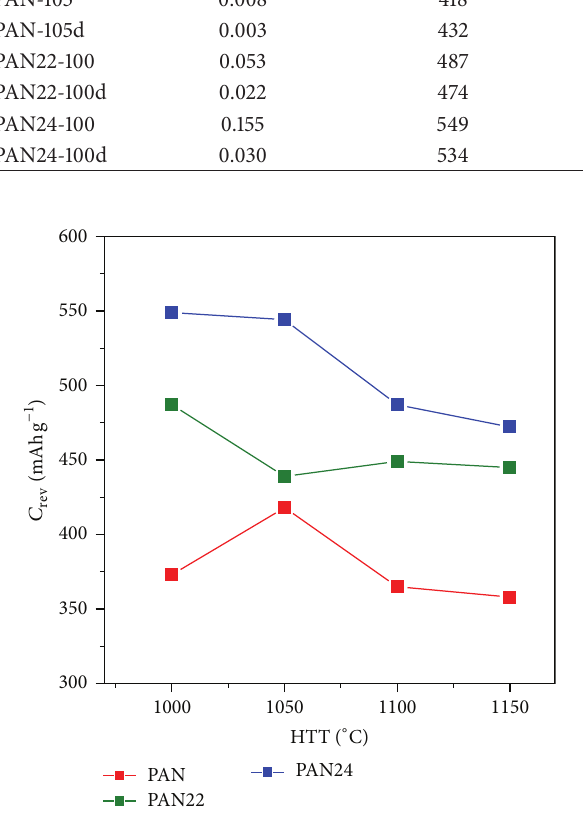
Figure 8: Variation of the reversible capacity with HTT of pristine and oxidized polyacrylonitrile.